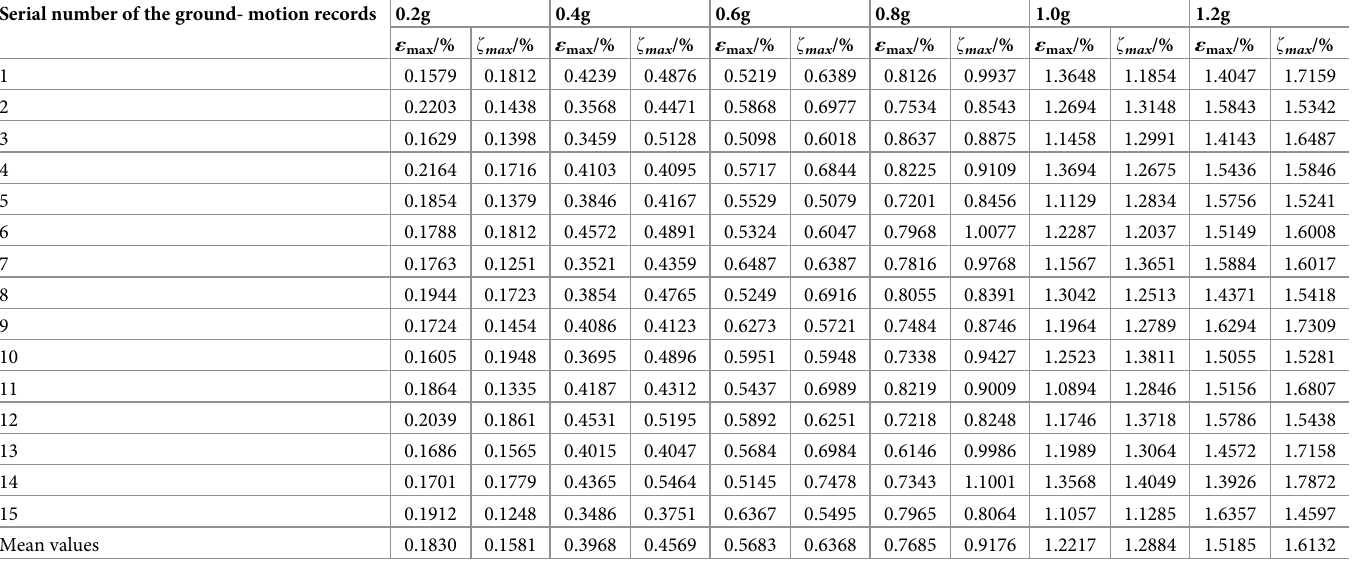
Table 4. Dynamic response analysis results of the embankment fill-soil foundation system. Serial number of the ground- motion records